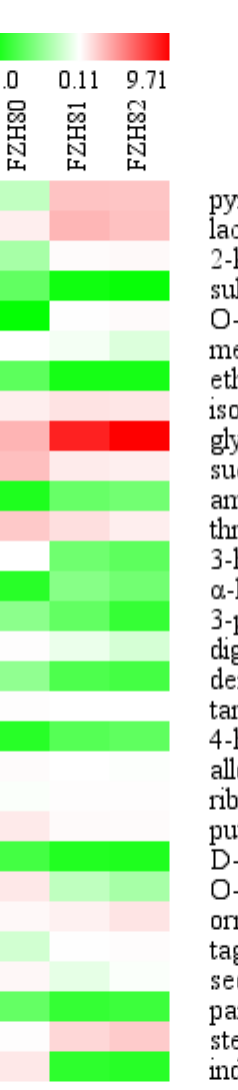
Figure 6. Heatmap of the abundance of marked metabolites in the fermentation broth of Epichloë sinen- sis when exposed to Se concentrations at a given time. Red and green blocks indicate higher and lower metabolite levels, respectively (see scale bar). FZH40, FZH41, and FZH42 represent fermentation broth for week 4 in the presence of 0, 0.1, or 0.2 mmol/L Na 2 SeO 3 , respectively. FZH50, FZH51, and FZH52 represent fermentation broth for week 5 in the presence of 0, 0.1, or 0.2 mmol/L Na 2 SeO 3 , respectively. FZH60, FZH61, and FZH62 represent fermentation broth for week 6 in the presence of 0, 0.1, or 0.2 mmol/L Na 2 SeO 3 , respectively. FZH70, FZH71, and FZH72 represent fermentation broth for week 7 in the presence of 0, 0.1, or 0.2 mmol/L Na 2 SeO 3 , respectively. FZH80, FZH81, and FZH82 represent fermentation broth for week 8 in the presence of 0, 0.1, or 0.2 mmol/L Na 2 SeO 3 , respectively. At Se concentrations of 0, 0.1, and 0.2 mmol/L, we detected 67, 47 and 39 marked metabo- lites, respectively, in the fermentation broth using statistical analysis ( p < 0.001) during the cultivation period (Figure 7). There were 25 common metabolites among Se concentrations, such as glycine, oxoproline, 4-aminobutyric acid, putrescine, lactamide, ethanolamine,